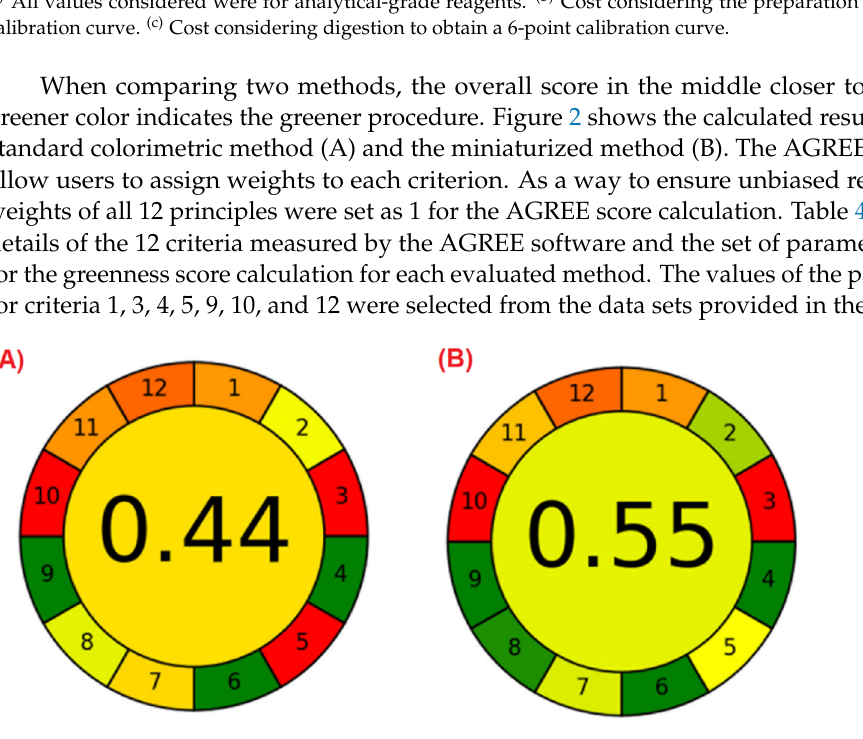
Figure 2. AGREE score results for ( A ) the standard colorimetric method and ( B ) the miniaturized method. Table 4. The twelve criteria measured by the AGREE software and the set of parameters used for the greenness score calculation for each method evaluated.